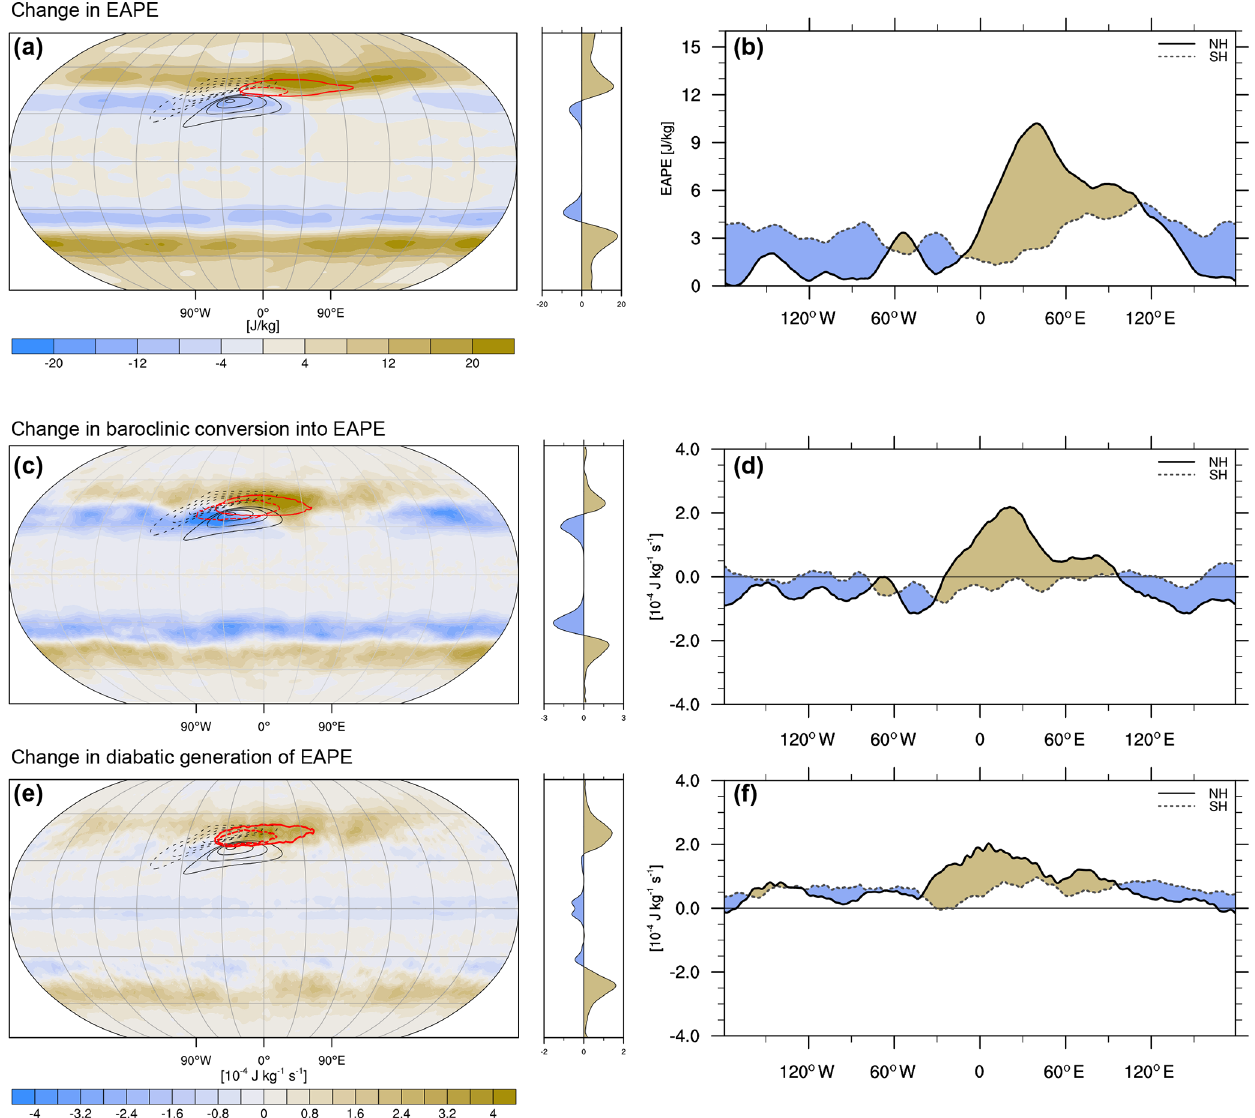
Figure 3. (a) EAPE difference between warmed and control simulations (mass-weighted vertically averaged between 1000–200hPa). Addi- tional red contours indicate selected EAPE value of 90Jkg − 1 in the control (red dashed) and warmed (red solid) simulations; (c) change in external baroclinic conversion and (e) diabatic generation rates of EAPE. Additional red contours in (c) and (e) indicate 8 × 10 − 4 J(kgs) − 1 in the control (red dashed) and warmed (red solid) simulations. (b) EAPE difference between the warmed and control simulations but merid- ionally averaged over the Northern Hemisphere (solid) and Southern Hemisphere (dashed) midlatitudes (20–60 ◦ N). Color shading highlights differences between the two hemispheres. (d, f) As (b) but for external baroclinic and diabatic EAPE